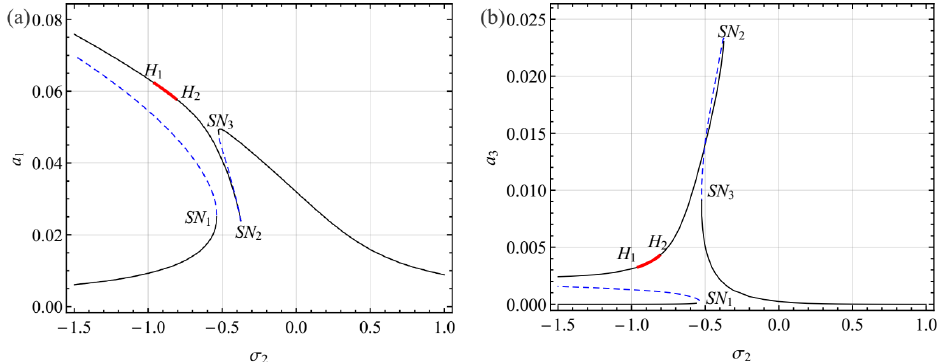
Figure 4. Frequency response curves for the first ( a ) and third ( b ) modes for V DC = 23.80, σ 1 = − 0.8059, V AC = 0.6.